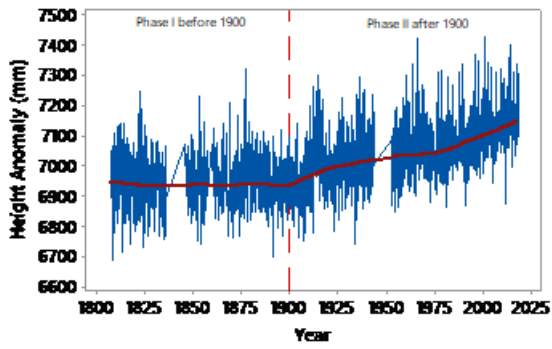
Fig. 1. Monthly averaged sea level height anomalies and their smoothed (Lowess) values at